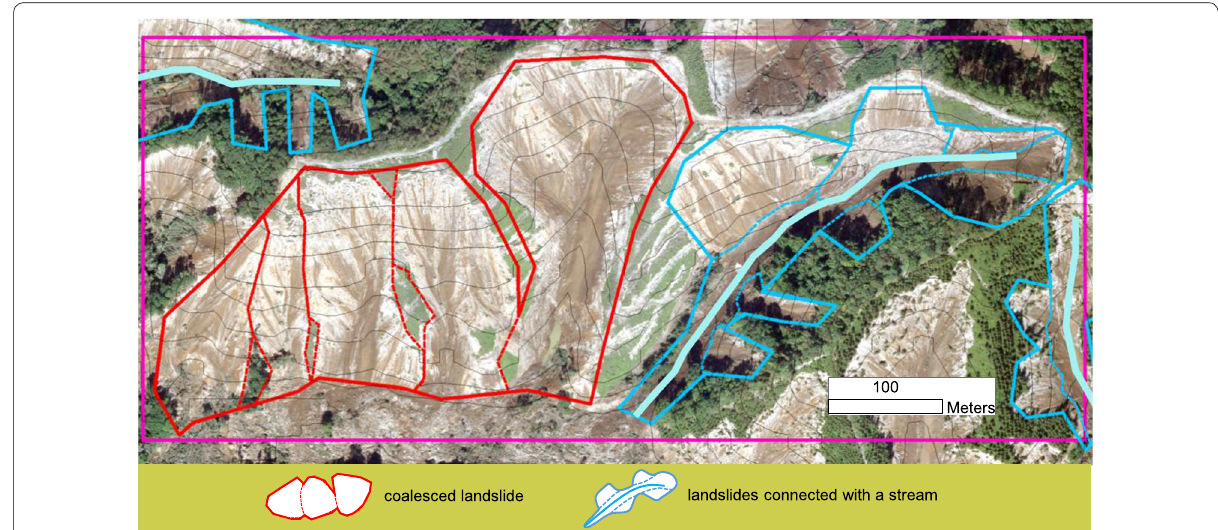
Fig. 5 Enlarged image of the area framed in pink in Fig. 3. Dashed lines divide individual identified landslides. Streams connected with landslides are indicated by pale blue lines. The contour interval is 10 m. The original inventory was produced by Kita (2018). This photograph was provided by the Hokkaido Regional Development